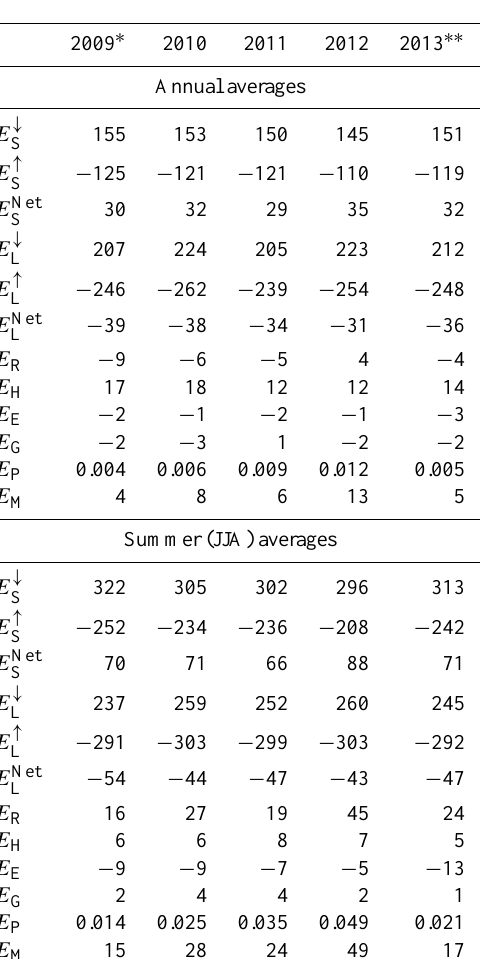
Table 5. Annual and summer (June–July–August) average energy fluxes at KAN_U (Wm − 2